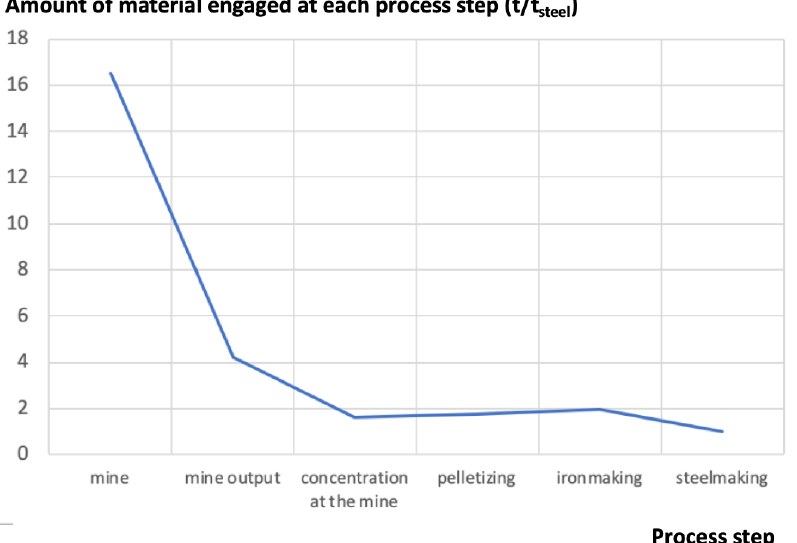
Figure 1. Amount of material engaged at each process step (in t). The final output of the process line is 1 t of crude steel (source: author).